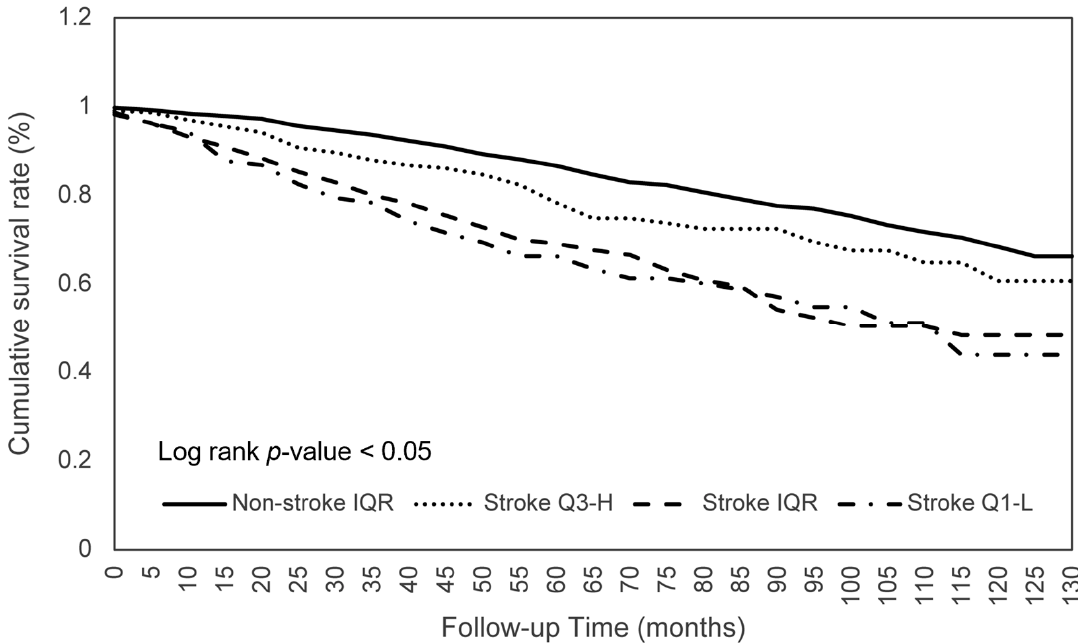
Figure 3. Total fat consumption in relation to the cumulative mortality rates. Abbreviations: Q1-L, Q1-lowest; IQR, interquartile range; Q3-H, Q3-highest.